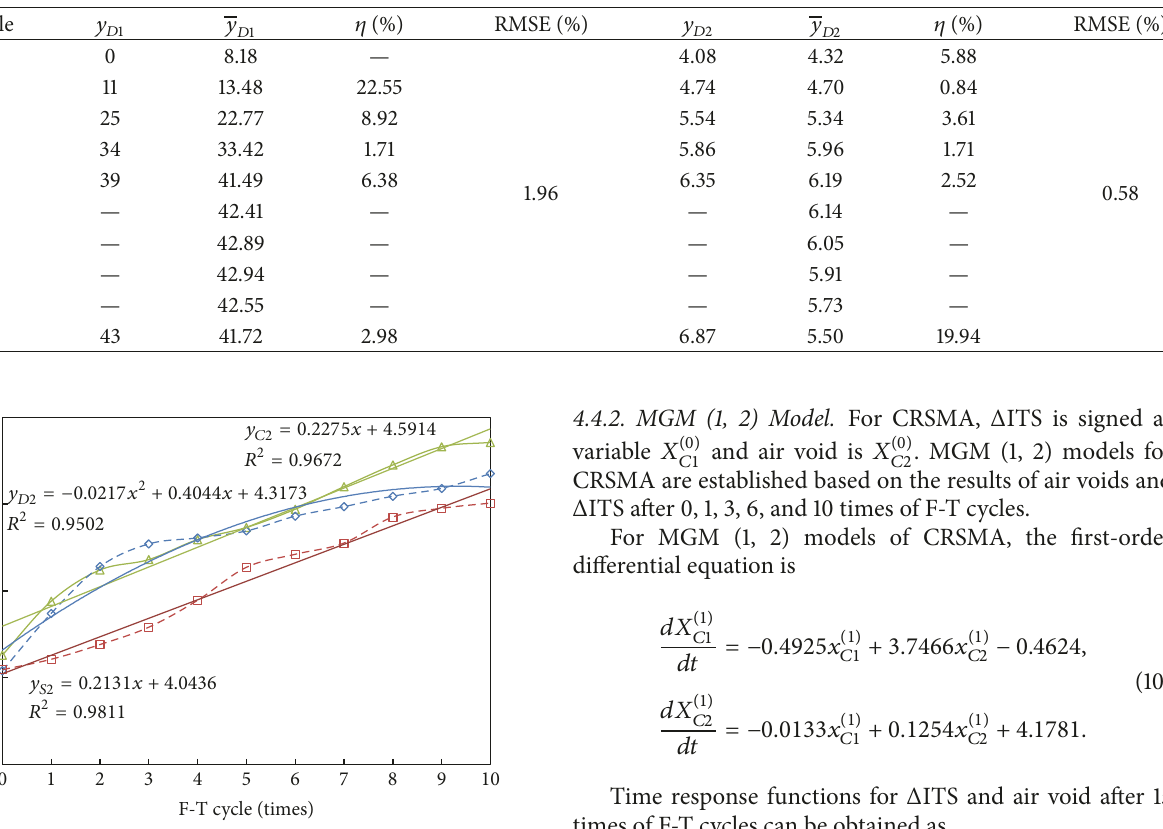
Table 11: Prediction results of 𝑦 𝐷1 and 𝑦 𝐷2 for CRDSMA based on regression model.